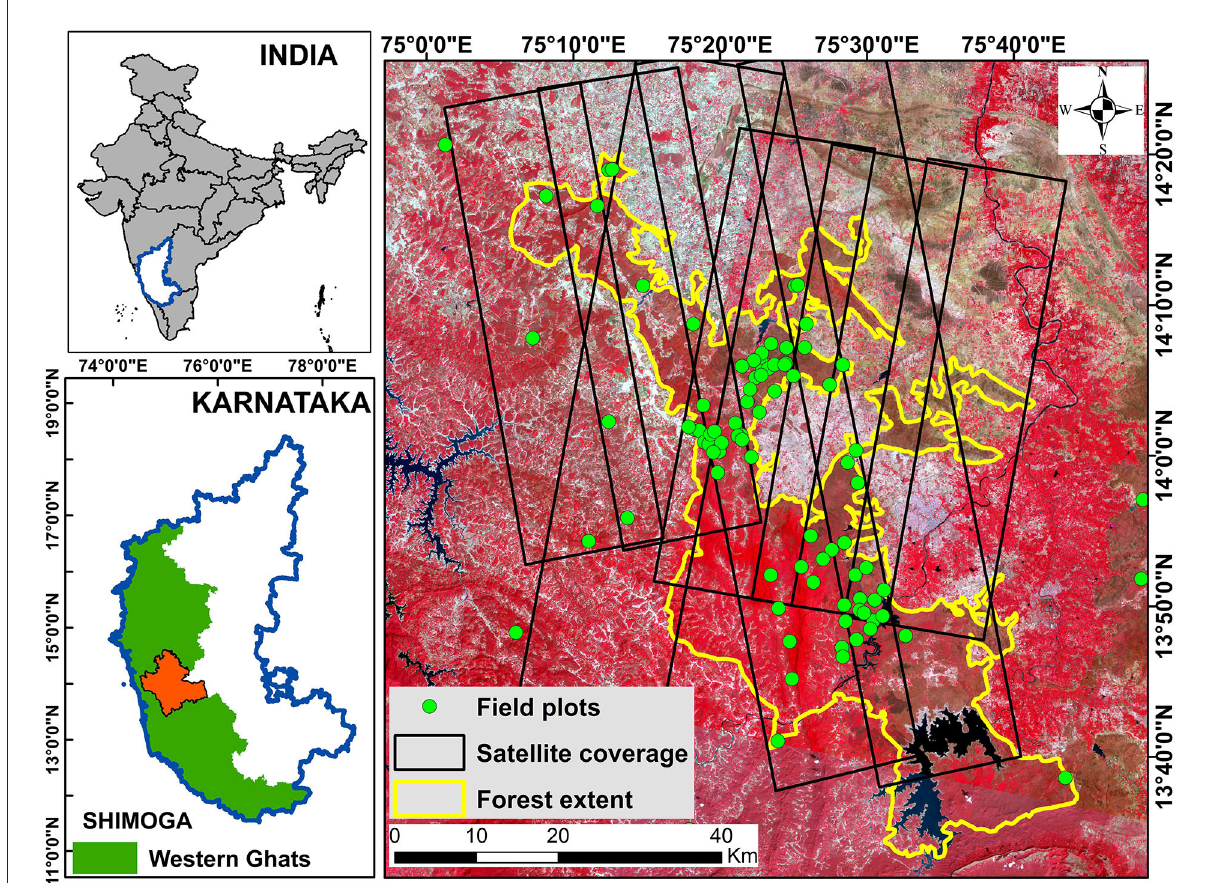
FIGURE1 The Shimoga Forest site situated in the Western Ghats region with the location of field plots (green circles). The yellow colored boundary shows the extent of forest in the study area. Multiple baseline TanDEM-X acquisitions over Shimoga Forest are represented as black boxes. The extent is overlaid on a Landsat-8 False Color Composite (FCC) image of